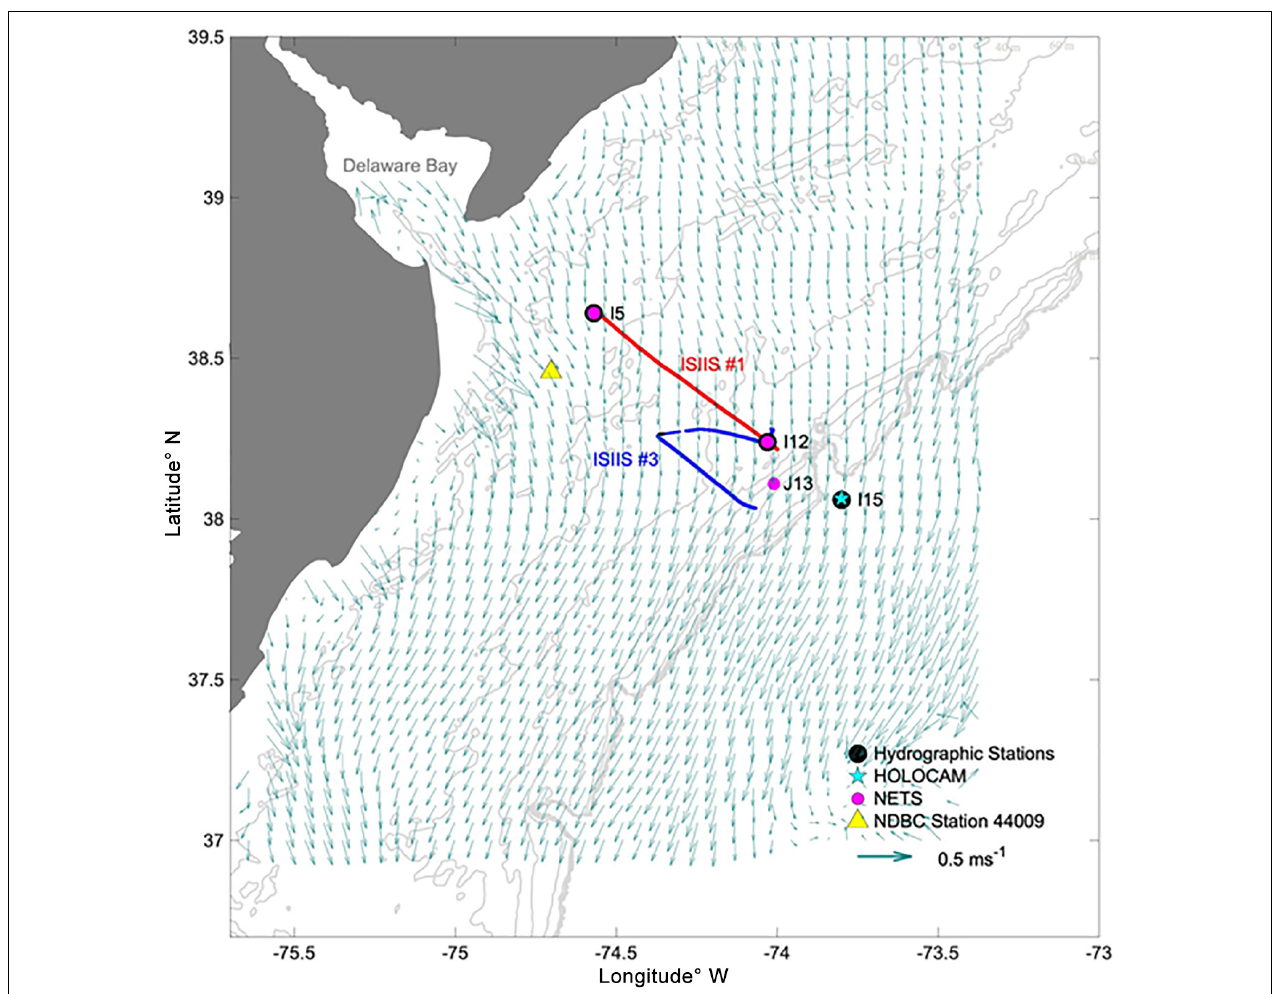
FIGURE 1 | Map of the sampling transects on April 28 and May 01, 2018. The points mark the locations of the hydrographic stations, net tows, HOLOCAM deployment, and wind velocity observations. Acoustic sampling occurred during ISIIS tow #1 but was not conducted during the U-shaped tow. Background arrows indicate the 25 h averaged currents derived from HF radar on April 29–30, 2018.